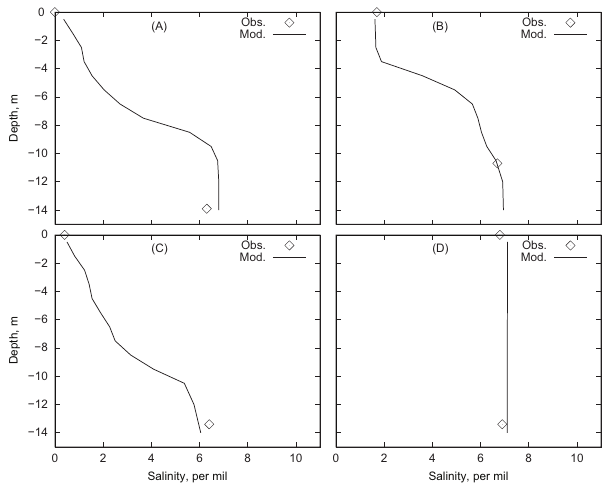
Fig. 3. Measured and modelled vertical salinity profile in Klaip ˙ eda Figure 3: Measured and modelled vertical salinity profile in Klaip ė da Strait at different time: 2 Strait at different time: (A) 5 February 2009, (B) 10 June 2009, (C) (A) 5 February 2009, (B) 10 June 2009, (C) 6 August 2009, (D) 8 September 2009. 3 6 August 2009, (D) 8 September 2009.